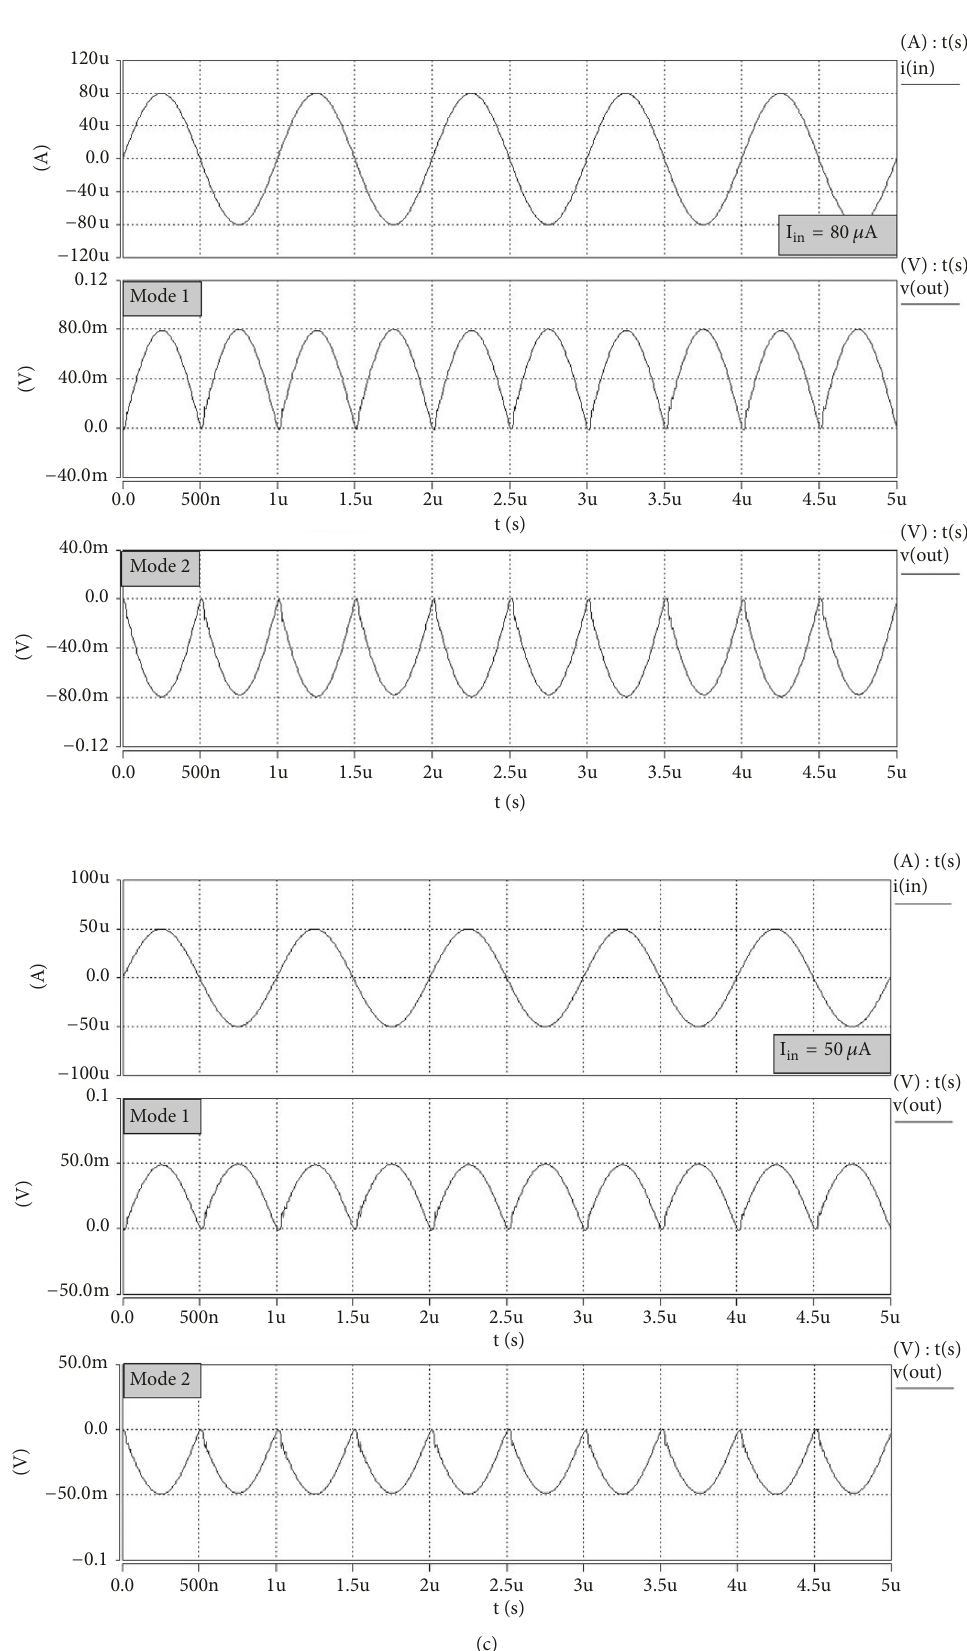
Figure 9: Simulation results of the input and rectified output waveforms of the circuit (Figure 4) at frequencies of (a) 1Hz, (b) 100kHz, and (c) 1 MHz for various input signal